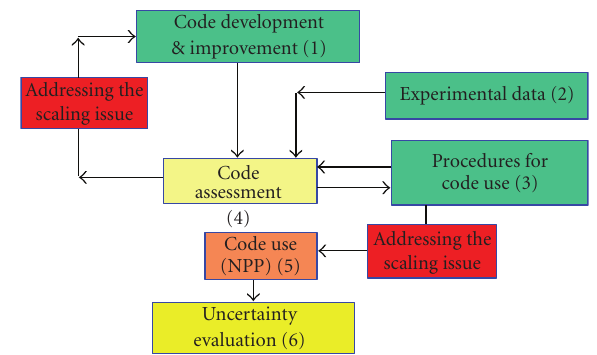
Figure 6: Role of the scaling analysis in the code assessment